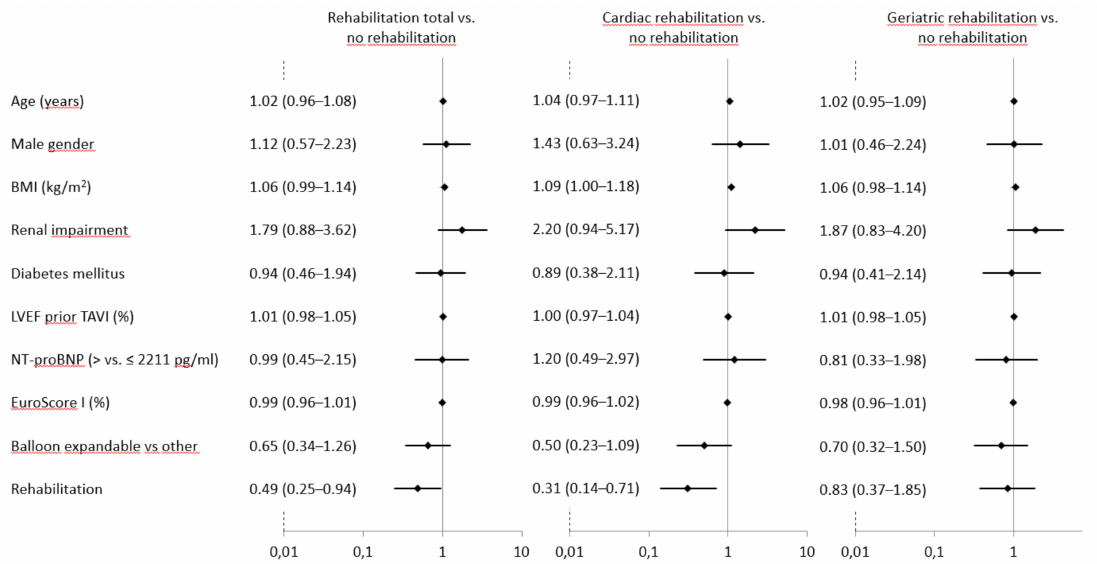
Figure 3. Variables associated with mortality at six months (multivariable adjusted). Legend: BMI, body mass index; renal impairment defined as glomerular filtration rate <60 mL/min; LVEF, left ventricular ejection fraction; TAVI, transcatheter aortic valve implantation; NT-pro BNP values were measured before TAVI.